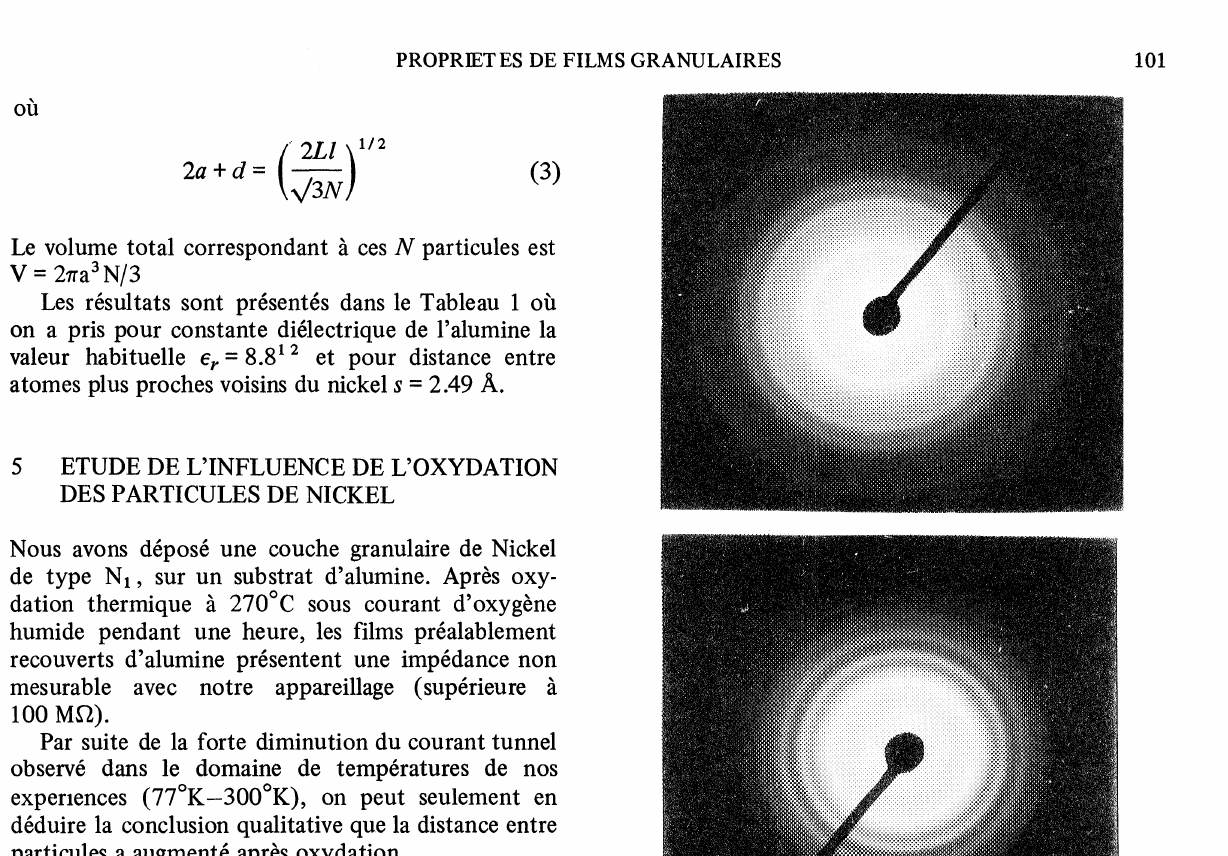
FIGURE 5 Diffraction lectronique sur un ensemble de particules de nickel. Nombre de coups